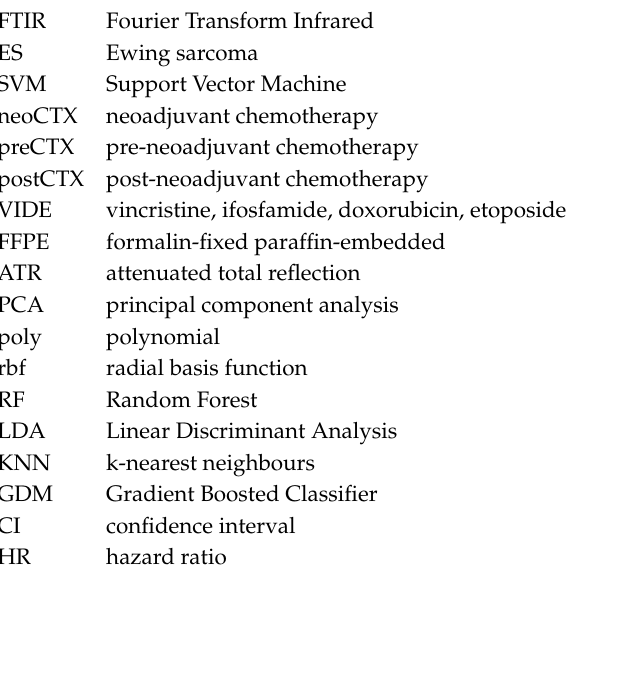
Supplementary Materials: Figure S1. Dimensionality reduction methods applied to the FTIR dataset. Patients who suffer necrosis are coloured red whilst those who do not are coloured blue. Matrix decomposition